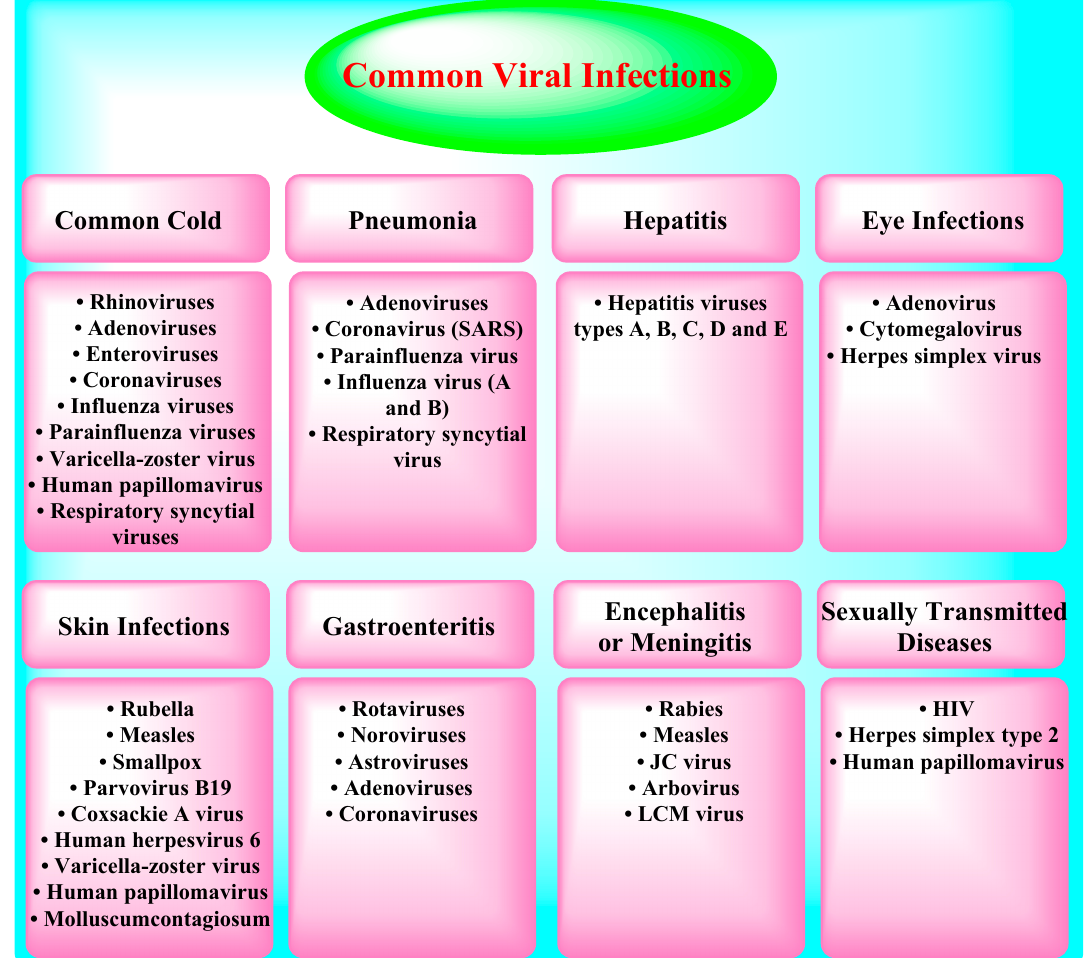
Figure 1. Types of common viral infections, the details are obtained from Ref. [9].